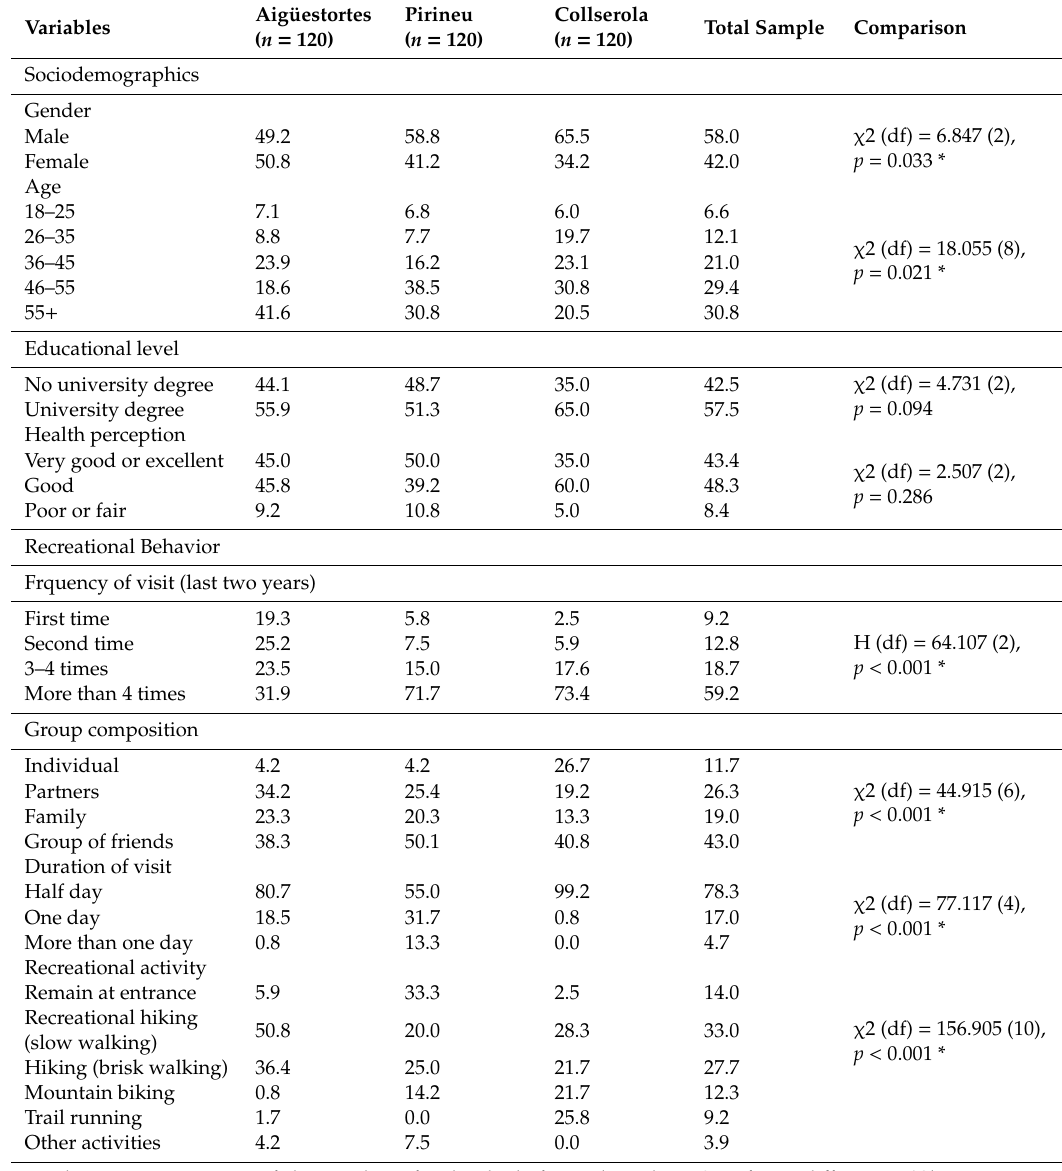
Table 2. Visitors’ sociodemographic characteristics and visit behavior in the three protected natural areas (PNAs) (N =